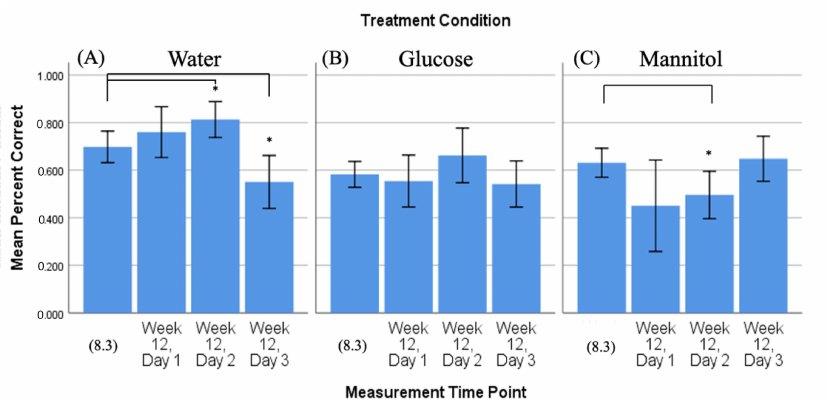
Figure 9. Comparison of 8-week vs. 12-week washout reversal. Mean percent correct scores (+/ − 95% CI) calculated on 8-week reversal day 3 (8.3) were compared (individual t -tests) to scores calculated on all three 12-week reversal days for ( A ) water-treated, ( B ) glucose-treated, and ( C ) mannitol-treated fish. At the 12-week timepoint, the fish had been exposed to hyperglycemic conditions for 8-weeks, followed by 4 weeks of recovery. Water-treated fish showed an increase in correct scores at day 2 ( p = 0.021), but a decrease on reversal day 3. The percent correct scores in glucose-treated fish were not different across all three reversal days or compared to 8.3. Mannitol-treated fish also had responses similar to 8.3, though the percentage of correct scores was reduced on reversal day 2 ( p = 0.021). Asterisks denote significant differences.